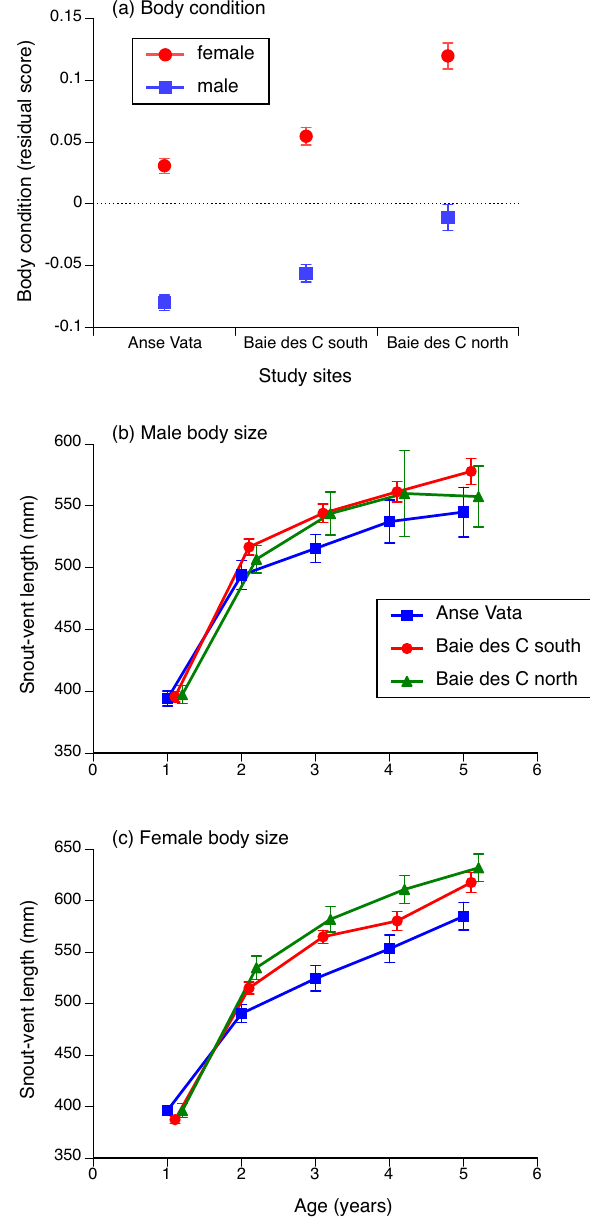
Figure 3. Variation among sites in attributes of turtle-headed sea snakes ( Emydocephalus annulatus ). Panel ( a ) shows body condition (residual score from the general linear regression of ln mass vs. ln snout-vent length, separately for males and females. Panels ( b ) and ( c ) show mean body sizes (snout-vent lengths) and associated standard errors for known-age snakes (based upon initial capture and marking as young-of-the-year). Panel ( b ) shows data for males, whereas panel ( c ) shows data for